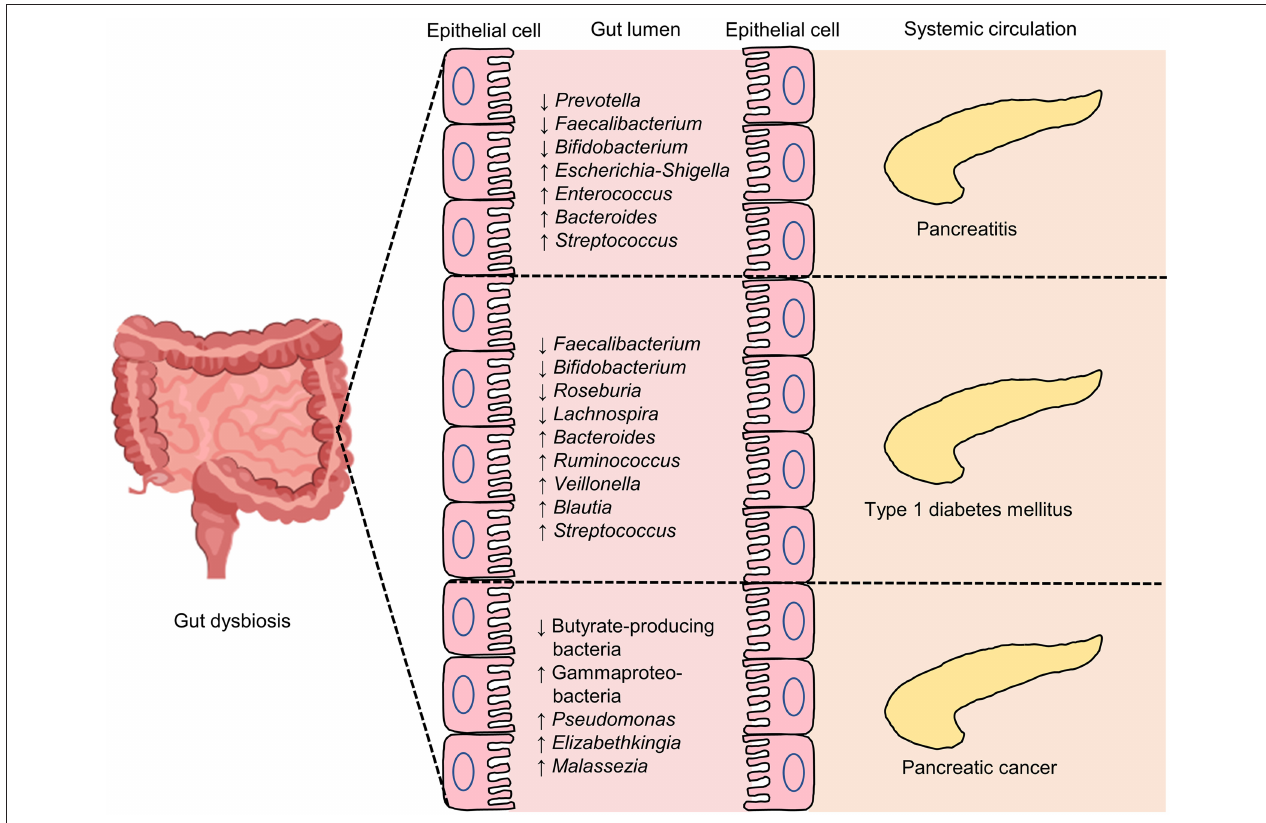
FIGURE 3 | Some of the reported intestinal microbial genic features in pancreatic diseases, including pancreatitis, type 1 diabetes mellitus (T1DM) and pancreatic cancer. An overview of selected key gut microbiome features related to pancreatic diseases. ↓ , lower abundance in pancreatic diseases when compared with control; ↑ , higher levels in pancreatic diseases when compared with